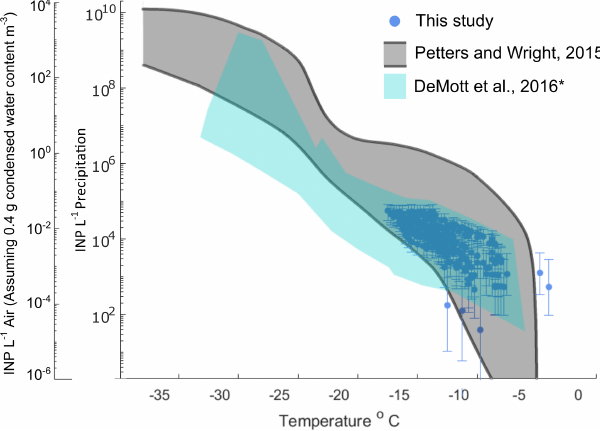
Figure 1. INP concentrations per liter of precipitation and esti- mated in-cloud INP concentrations per volume of air in 15 precip- itation samples collected at two coastal sites at Scripps Institution of Oceanography (La Jolla, California, USA) between 22 Septem- ber 2016 and 22 November 2019. Grey shaded region indicates the spectrum of INP concentrations reported in nine previous studies of precipitation and cloud water samples collected from various seasons and locations worldwide, adapted from Fig. 1 in Petters and Wright (2015). The blue shaded region denotes the compos- ite spectrum of INP concentrations observed in a range of marine and coastal environments including the Caribbean, east Pacific, and Bering Sea as well as laboratory-generated nascent sea spray (De- Mott et al., 2016). ∗ DeMott et al. (2016) data have been updated with a completed dataset for the ICE-T study, as shown in Yang et al.